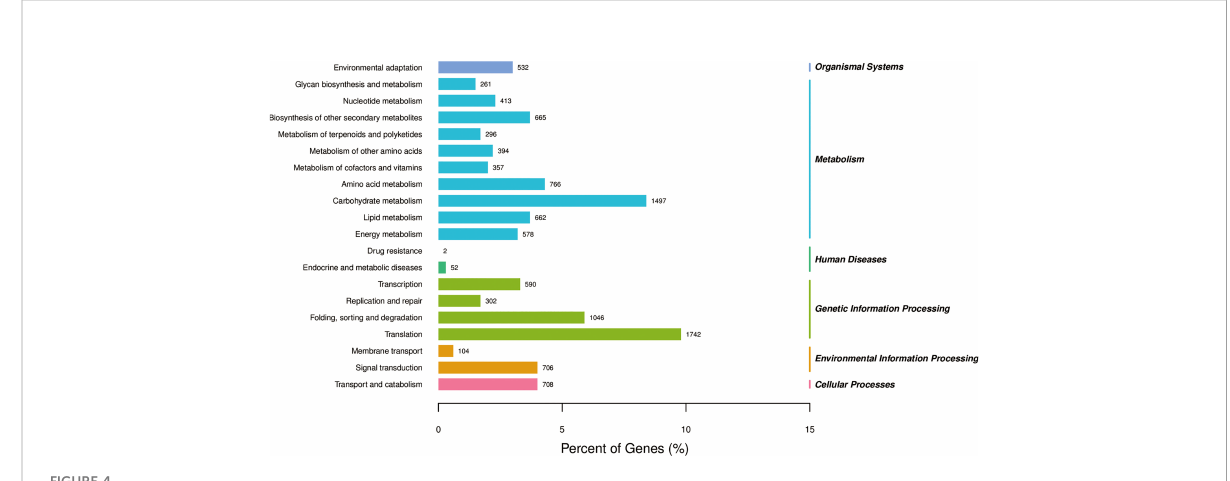
FIGURE 4 KEGG pathway categorization of the